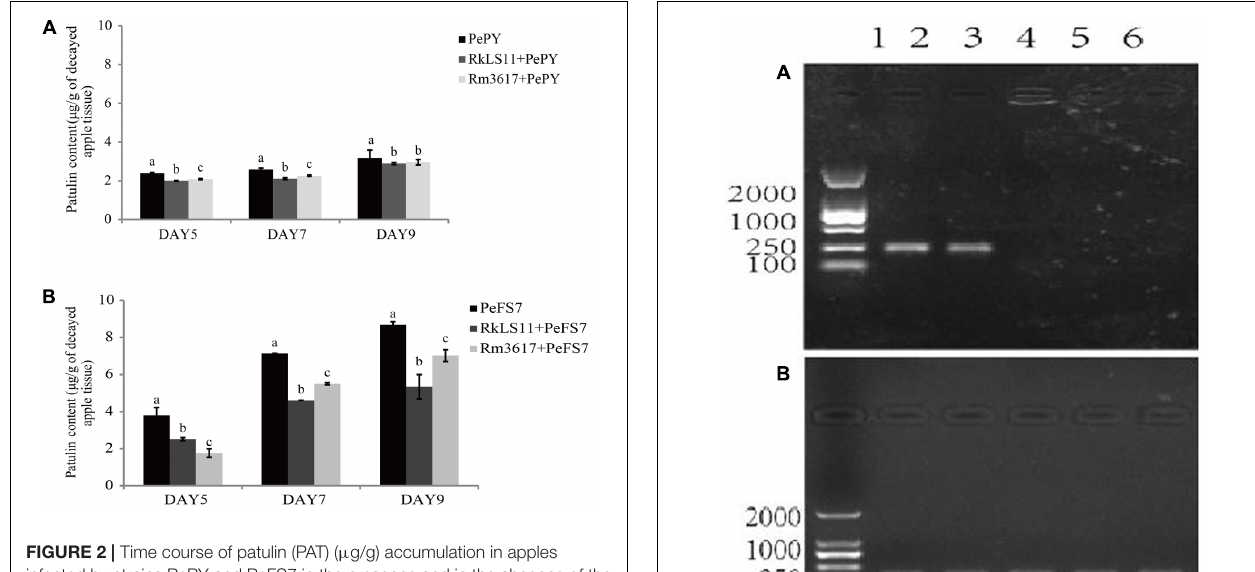
FIGURE 2 | Time course of patulin (PAT) ( µ g/g) accumulation in apples infected by strains PePY and PeFS7 in the presence and in the absence of the biocontrol yeasts Rhodotorula mucilaginosa strain 3617 and R. kratochvilovae strain LS11. (A) PAT accumulation caused by Penicillium expansum strain PePY. (B) PAT accumulation caused by P. expansum strain PeFS7. Bars represent the mean values from two experiments ± standard deviations. Values marked with different letters are significantly different ( P < 0.05). FIGURE 3 | Agarose gel electrophoresis showing the assessment of